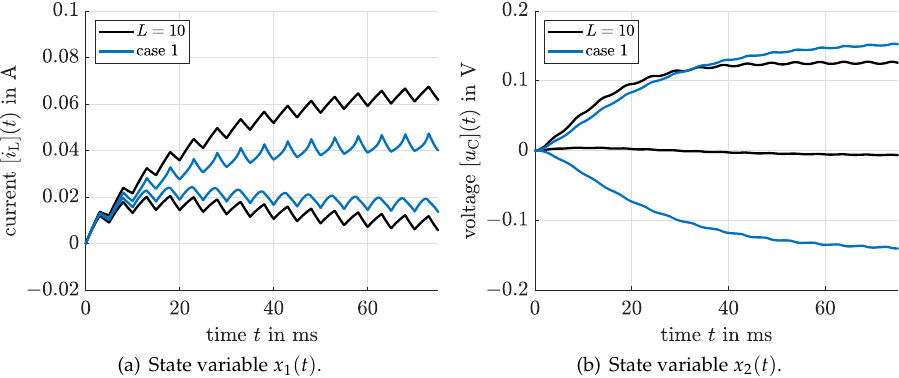
Figure 6. Comparison of the proposed approach with L = 10 with the results of verifyode for the case 1 .